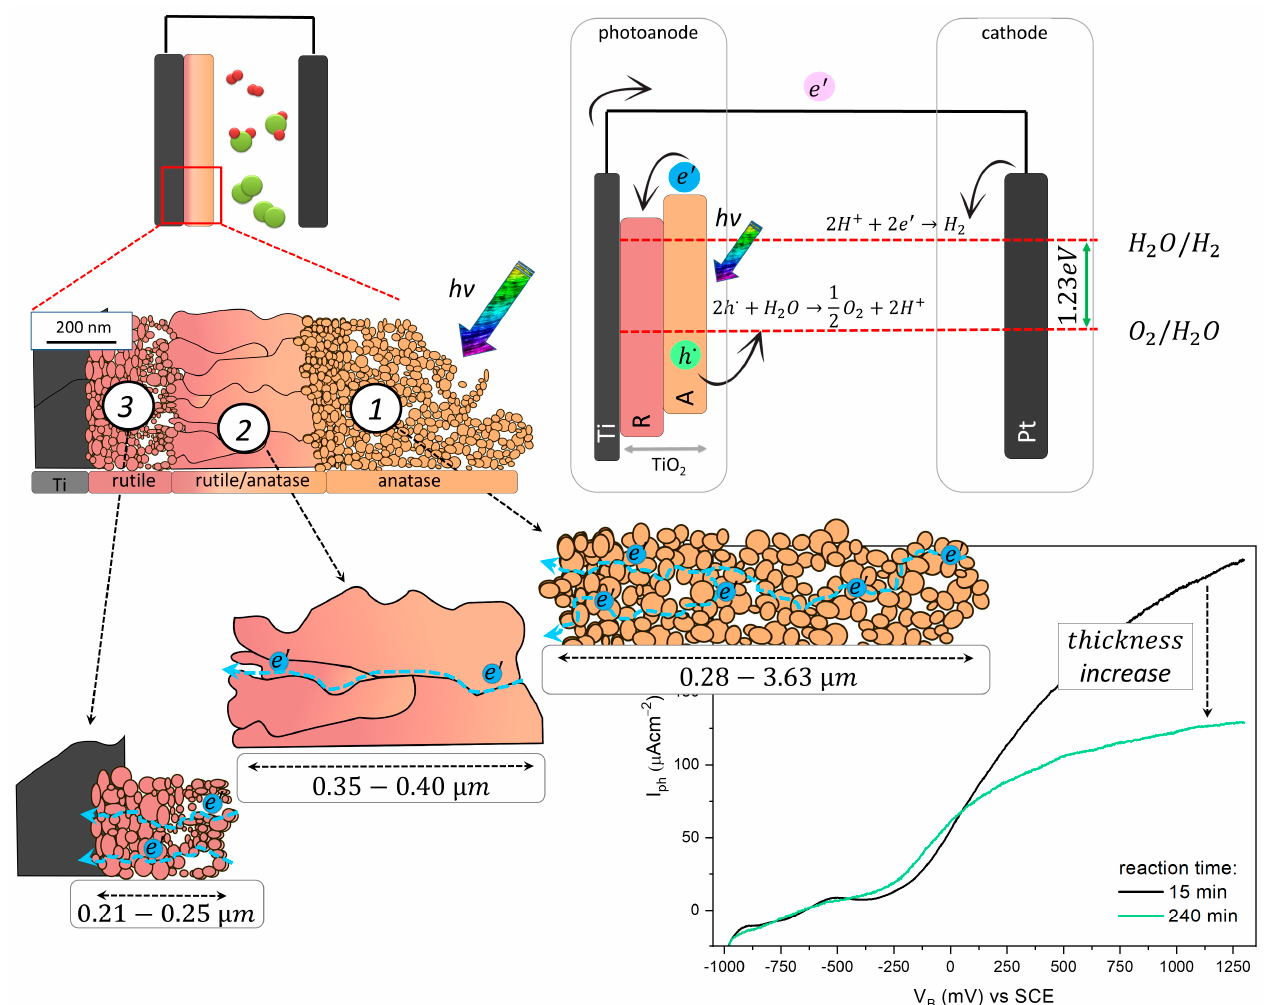
Figure 9. Schematic diagram of the processes that occur in PEC cells with a photoanode based on flower-like TiO 2 .